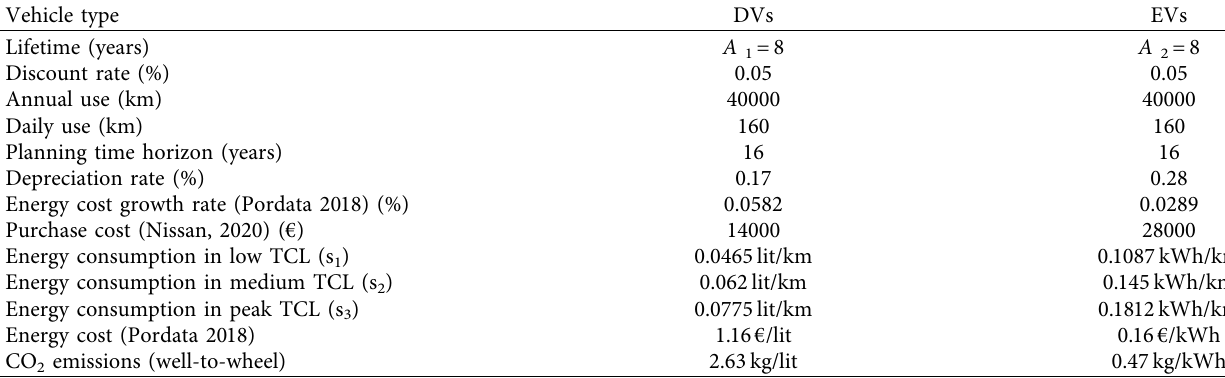
Table 1: Input-parameter data.